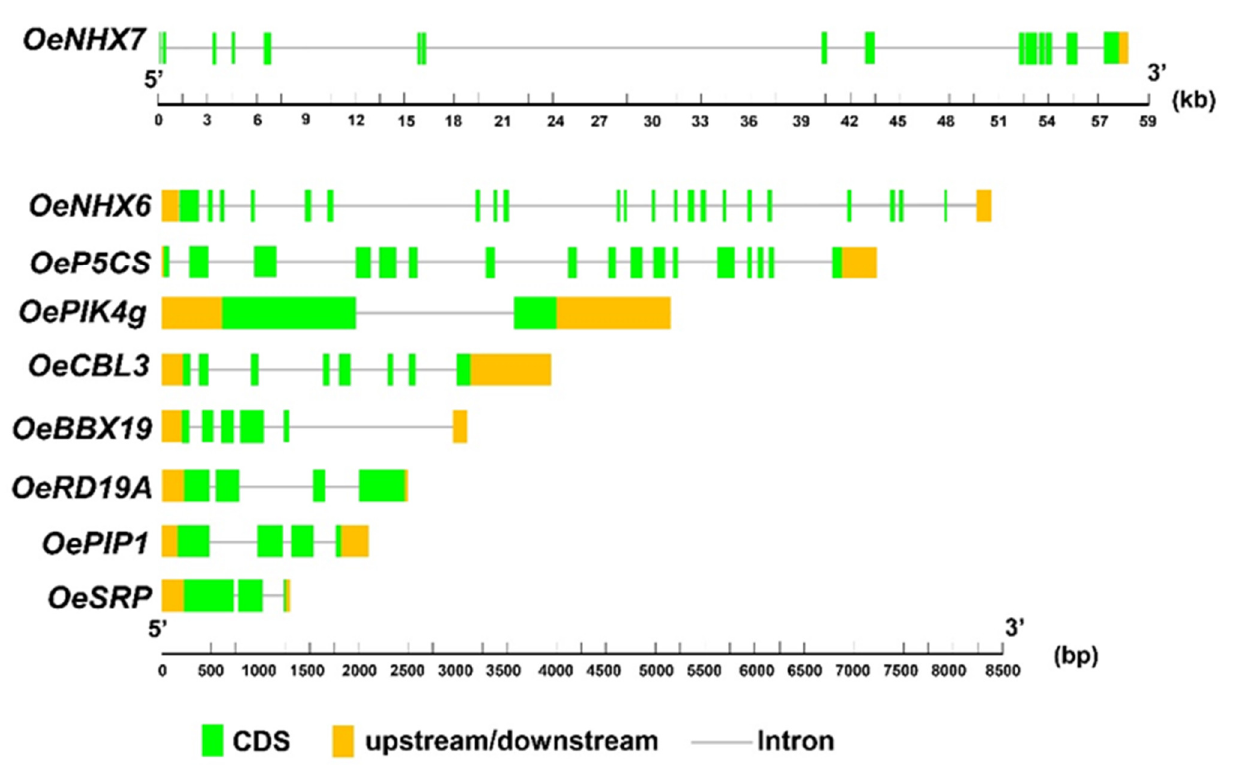
Figure 4. Gene structure of ten genes was identified in the present study in olive